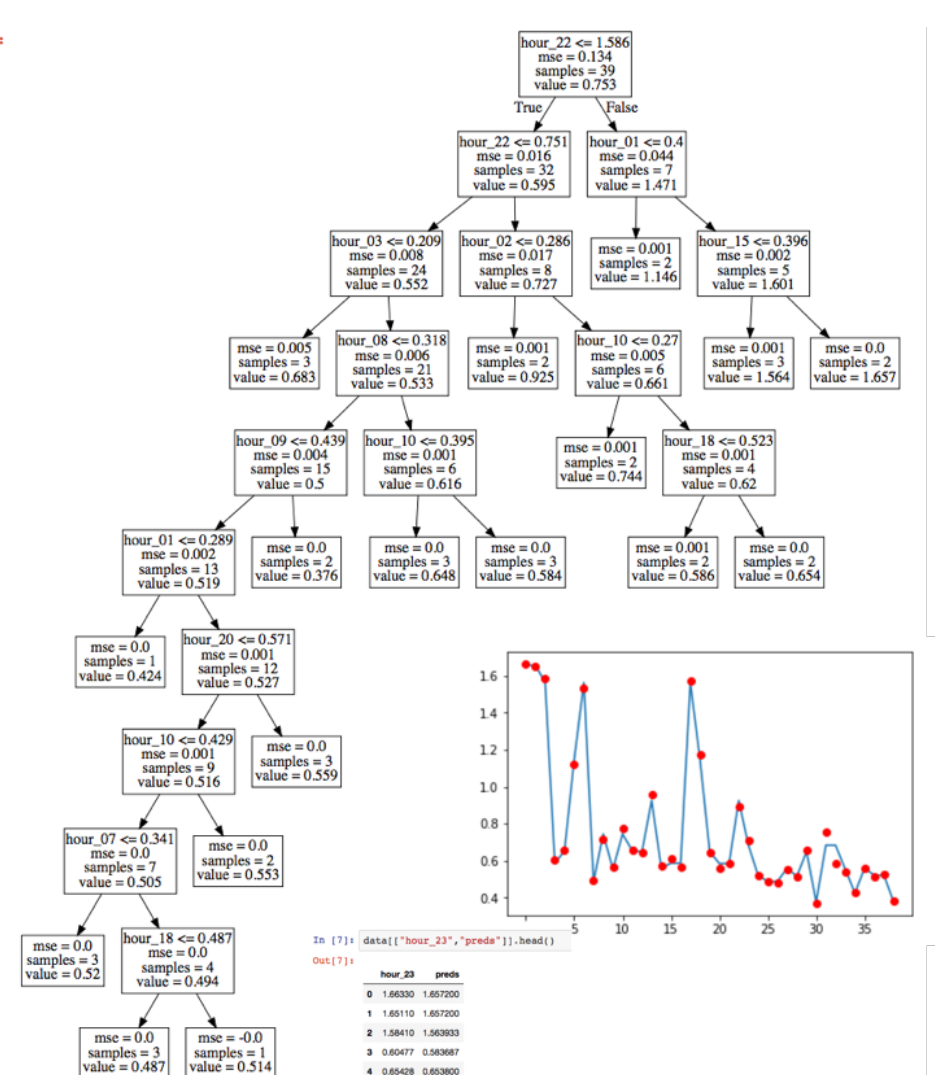
Figure 16. Regression tree obtained to predict power consumption hourly. The blue line represents the measured consumption and the red points the prediction made by the